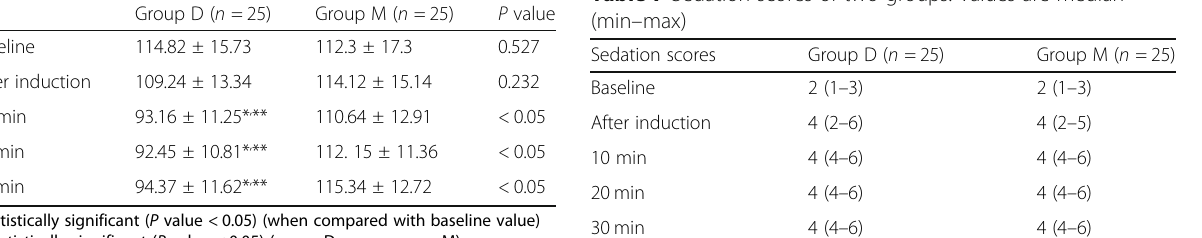
Table 7 Sedation scores of two groups. Values are